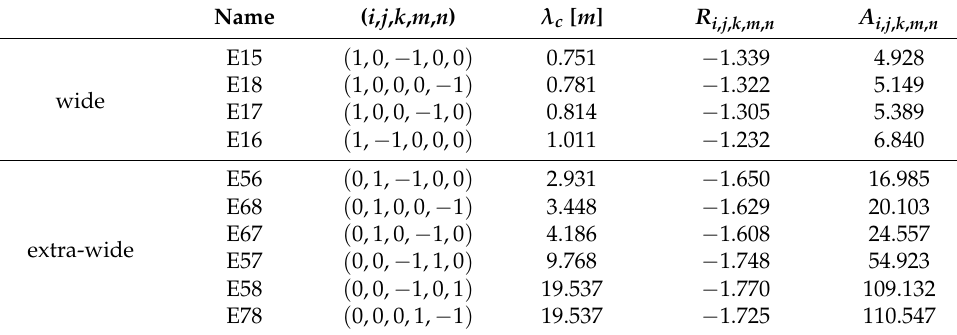
Table 3. Wide-lane combination of Galileo.